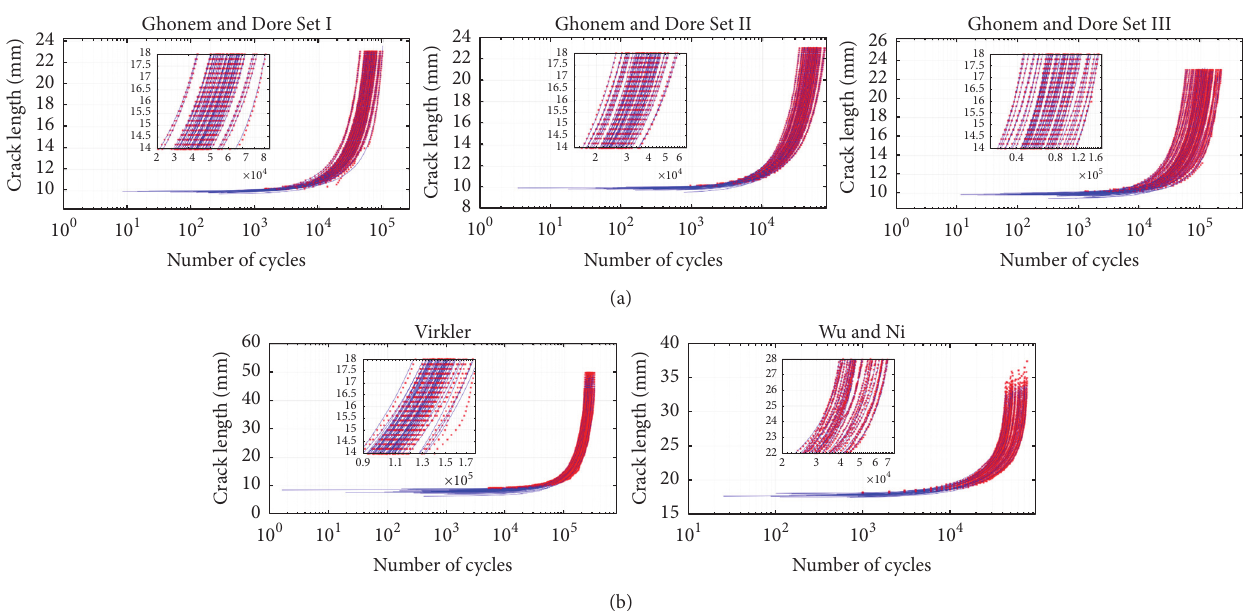
Figure 4: Comparison of raw (dots) and analytical (lines) crack length versus number of cycles for the 5 datasets.